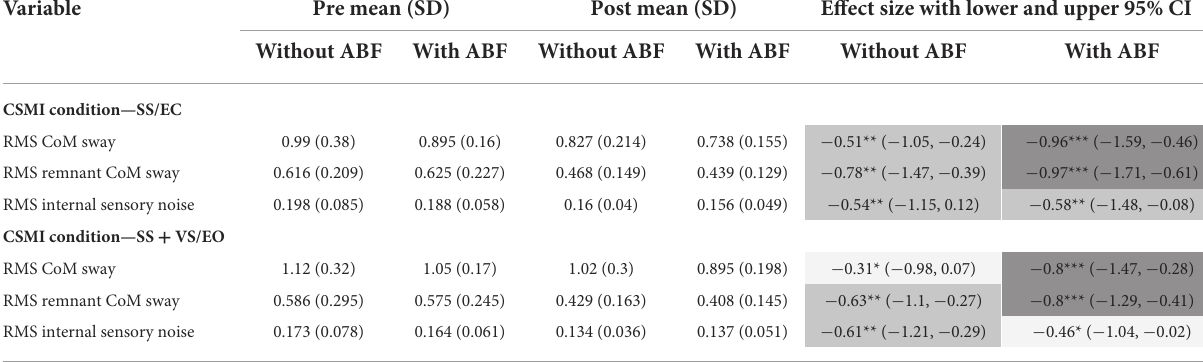
TABLE 5 Means, standard deviations (SD), and effects sizes with lower and upper 95% confidence limits (Cl) for rehabilitation without and with audiobiofeedback (ABF) groups pre- and post-rehabilitation on Central Sensorimotor Integration (CSMI) test measures of sway. Variable Pre mean (SD) Post mean (SD) Effect size with lower and upper 95% CI Without ABF With ABF Without ABF With ABF Without ABF With